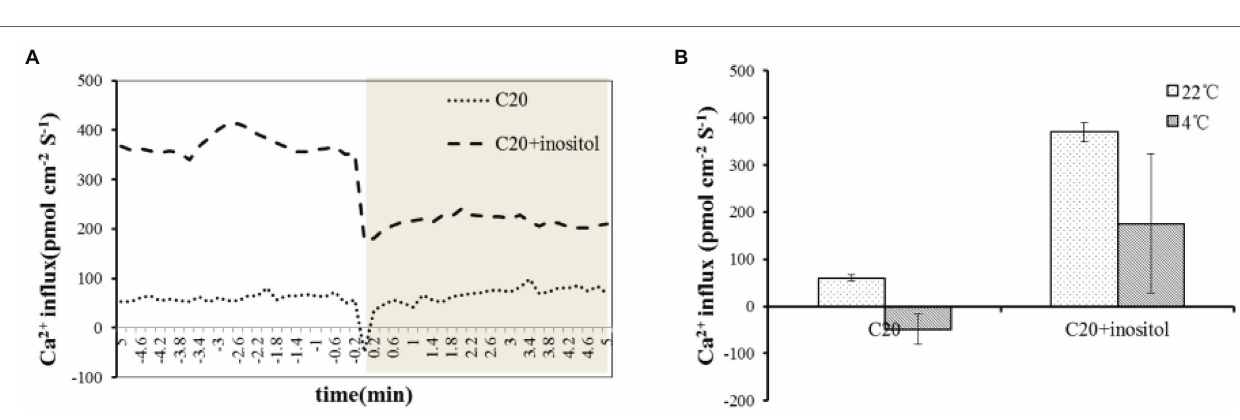
FIGURE 4 | Ca 2+ influx upon Cold Shock in C20 spayed water and inositol. (A) NMT measurements show extracellular Ca 2+ influx upon on cold shock in live leaves of C20 spayed with water and inositol ( n = 3). (B) The mean Ca 2+ fluxes in 22 ° C and 4 °